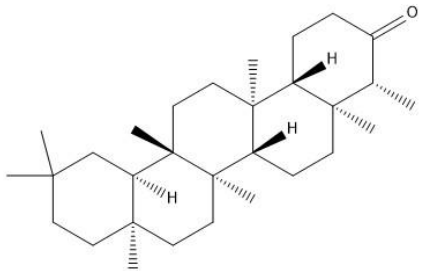
Figure 1. 2D structure of friedelin.